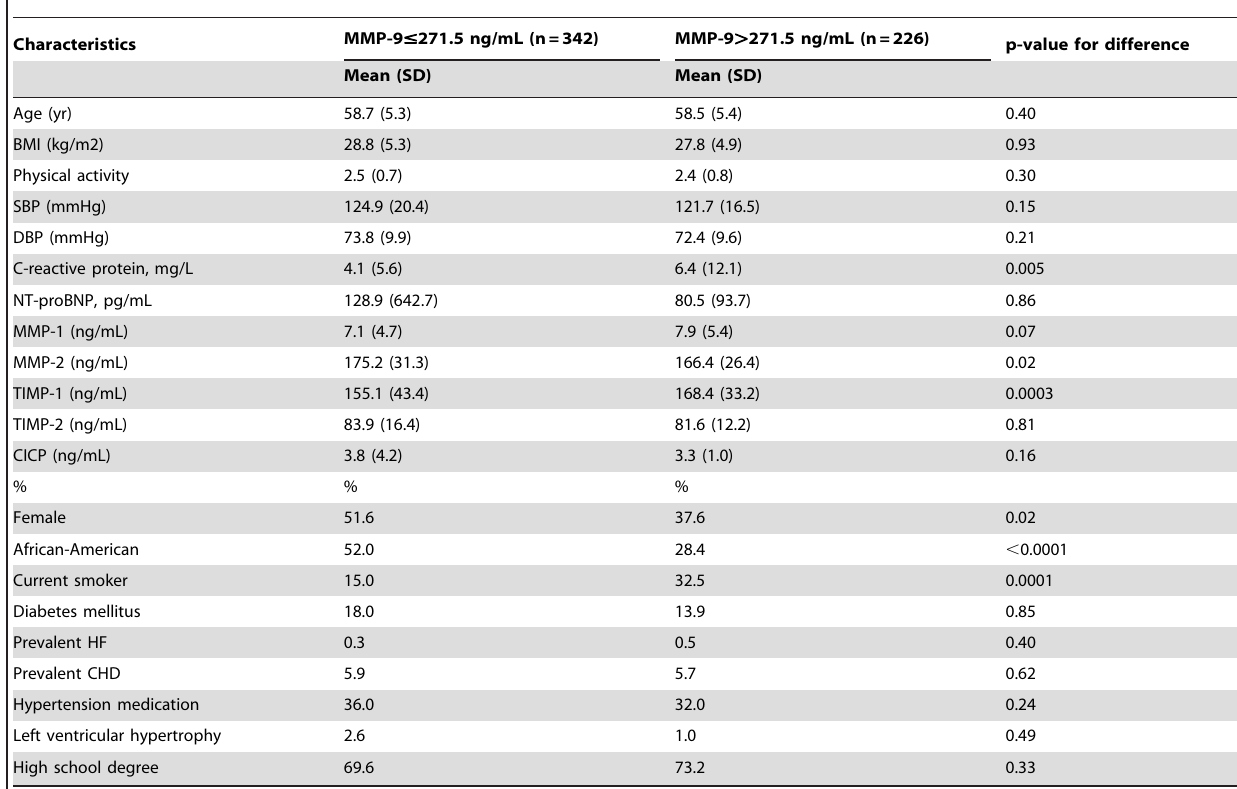
Table 4. Baseline characteristics of individuals dichotomized by whether they had above or below the mean value (271.5 ng/mL) of MMP-9 in the cohort random sample